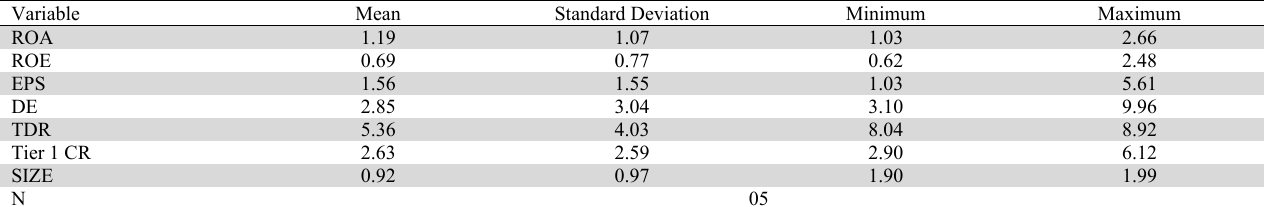
Summary of some descriptive statistics